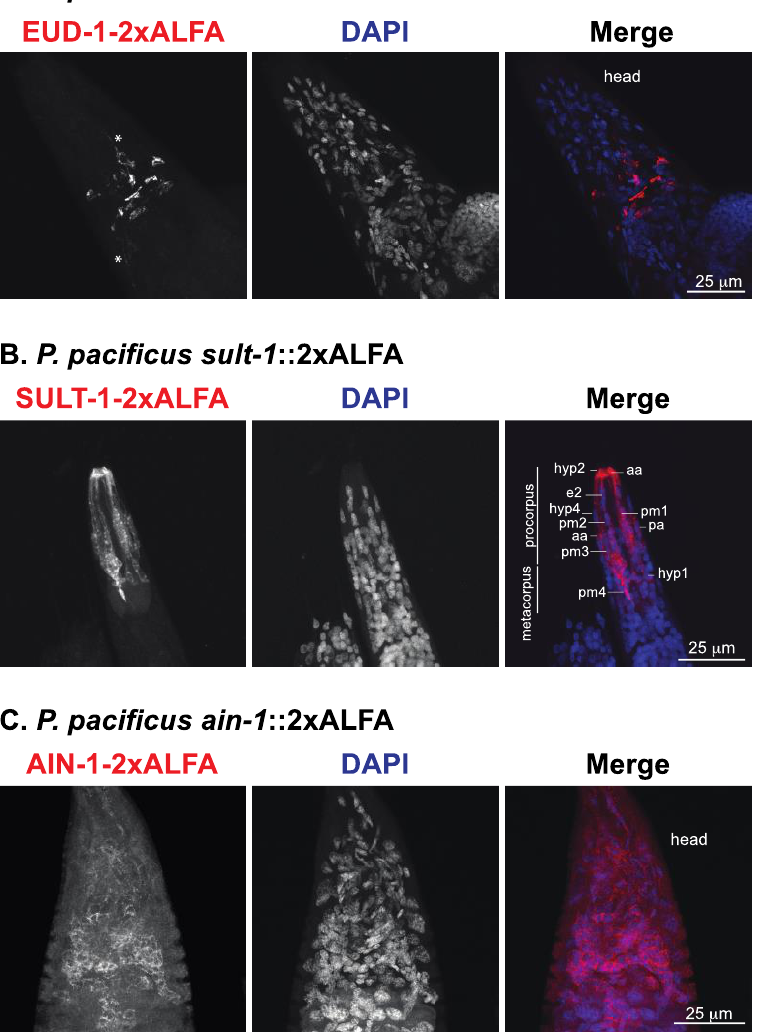
Figure 3. ALFA-tagged proteins show distinct expression patterns in P. pacificus ( A–C ) Representative confocal fluorescent micrographs of the head of fixed P. pacificus eud-1(tu1729 [ eud-1 ::2xALFA]) ( A ), sult-1(tu1760 [ sult-1 ::2xALFA]) ( B ) and ain-1(tu1753 [ ain-1 ::2xALFA]) ( C ) animals. The worms were stained with anti-ALFA fluorescent nanobody. The merged images show the anti-ALFA signal in red and the nuclei in blue (DAPI staining). To maximize the expression of the sulfotransferase, sult-1(tu1760 [ sult-1 ::2xALFA]) animals were grown under liquid culture conditions. Images depict J4/adult worms. In A, asterisks indicate neuronal projections. In B, cell types were identified based on the reconstruction of the head hypodermis in P. pacificus [40]. aa: anterior arcade cell, e: epidermal cell, hyp: hypodermal syncytia, pm: pharyngeal muscle